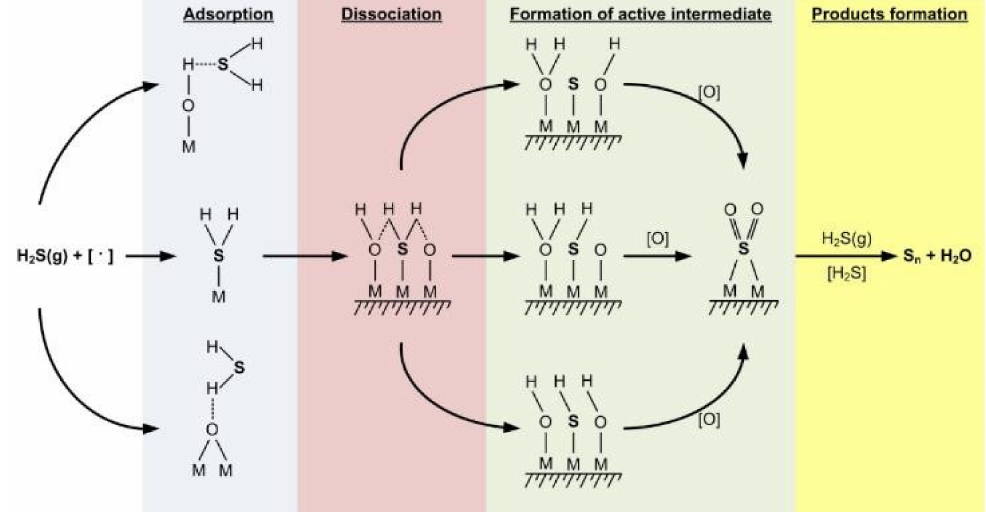
Figure 13. Proposed mechanism of H 2 S oxidation on oxide catalysts.